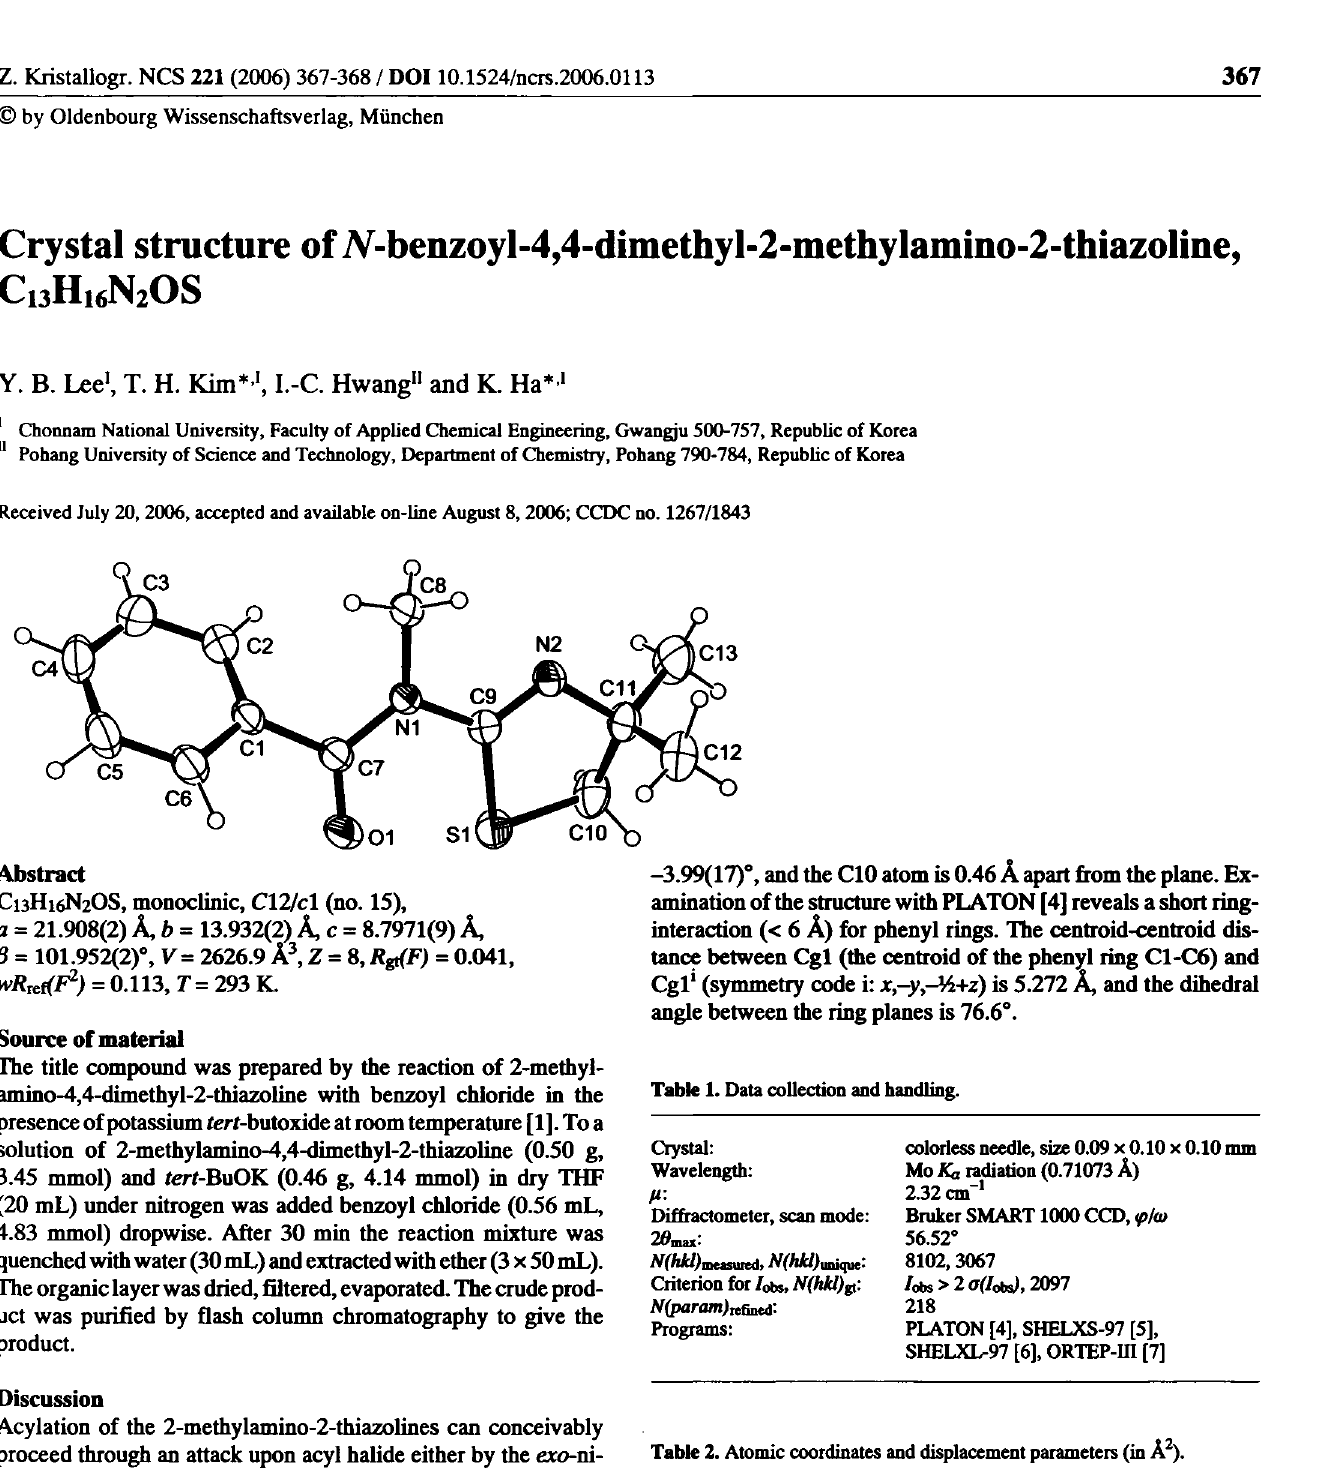
Table 2. Atomic coordinates and displacement parameters (in A 2